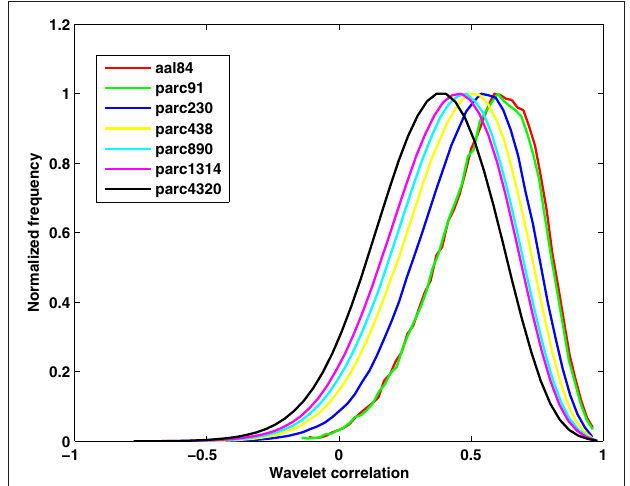
FIguRe 2 | Functional connectivity histograms obtained at each parcellation scale. Each line corresponds to the sample average histogram of correlation values contained in each participant’s unthresholded functional connectivity